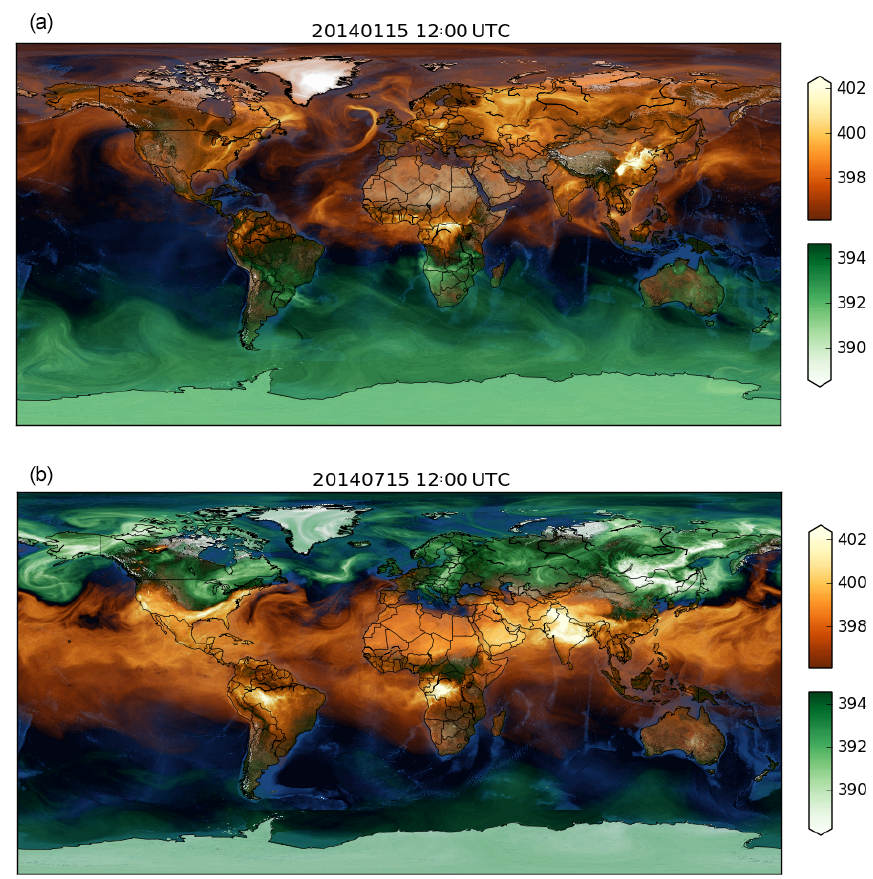
Figure 1. Snapshots of column-averaged CO 2 (XCO 2 ) (ppm) above (in reds) and below (in greens) the global mean on 15 January (a) and 15 July (b) at 12:00UTC from the Copernicus Atmosphere Monitoring Service global CO 2 forecast at high horizontal resolution ( ∼